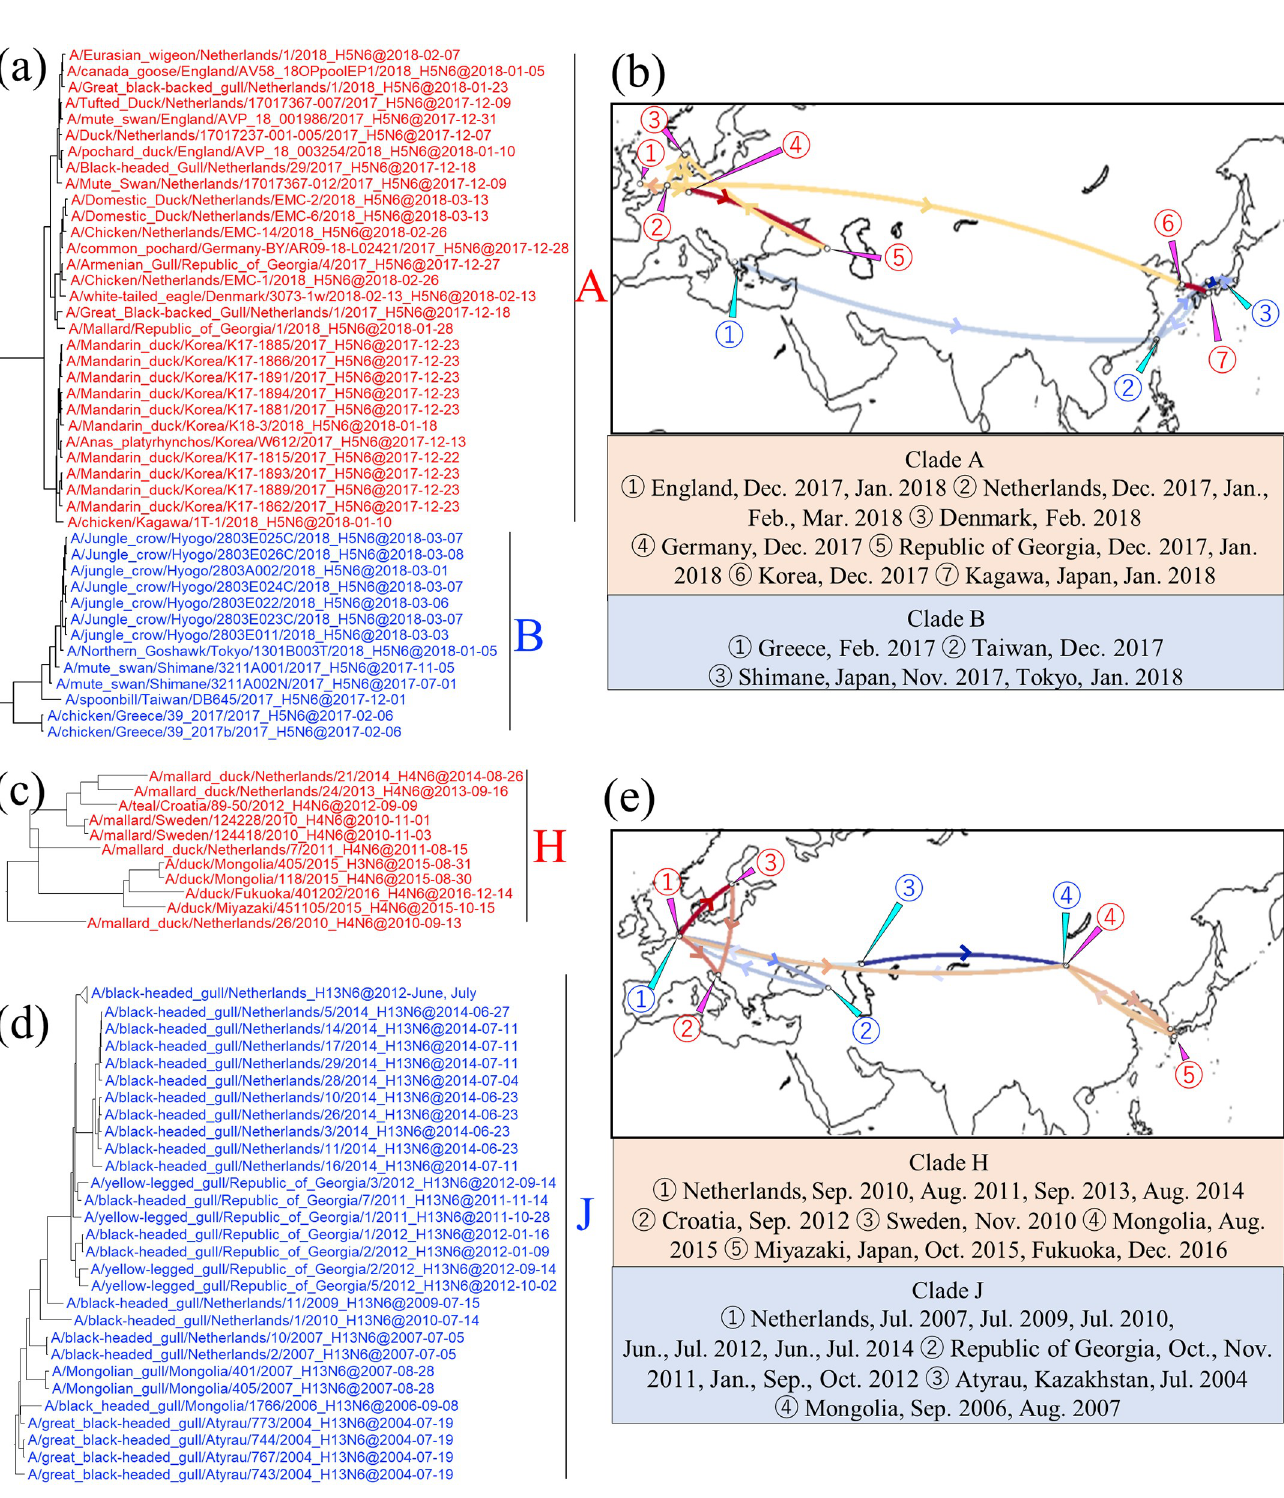
Fig 3. Detail of maximum clade credibility (MCC) phylogenetic trees of N6 NA genes in clades A, B, H, and J and visualized location-annotated MCC trees for selected clades on the world map. Clades A and B are red and blue, respectively, in tree (a), and colored type lines in (b) correspond to the clade colors. Clades H and J are red type and blue type, respectively, in each tree (c and d), and colored type lines in (e) correspond to those of clades. Lines with Bayes factors of 3.0 or more are shown in the map, and a deeper color means a higher Bayes factor.